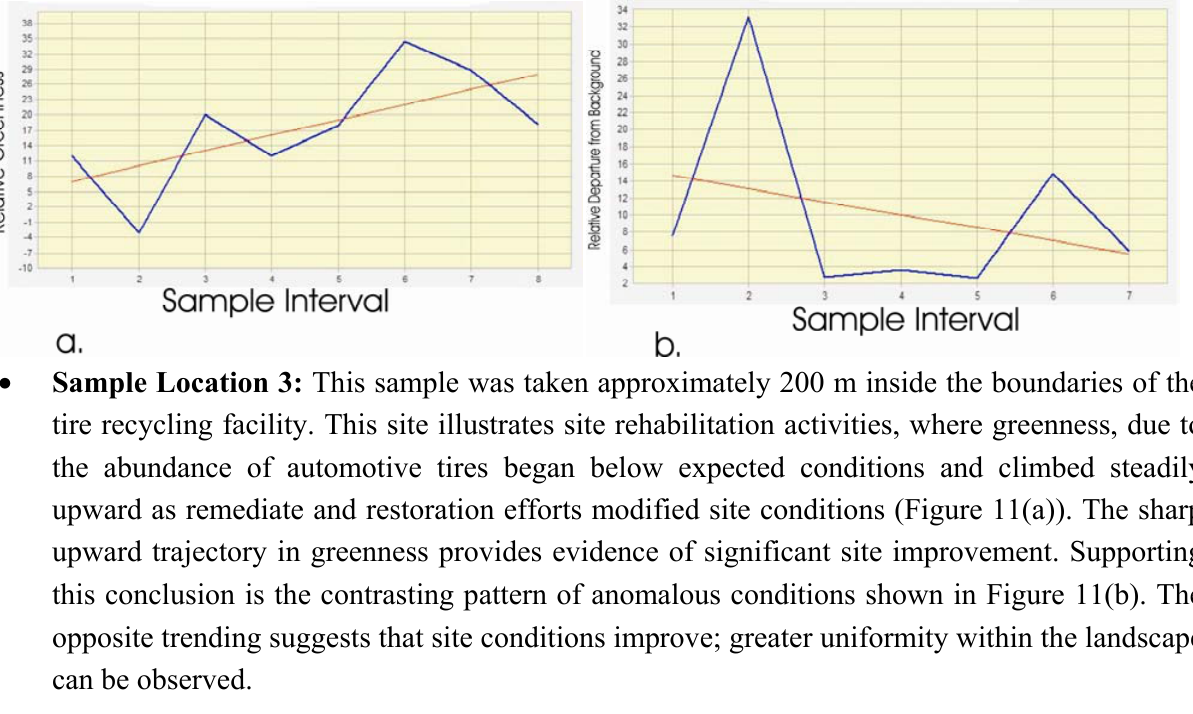
Figure 10. Greenness (a) and Anomaly (b) profiles for Sample #1 covering anniversary dates from 1998 through 2009 with x-axis not to scale.